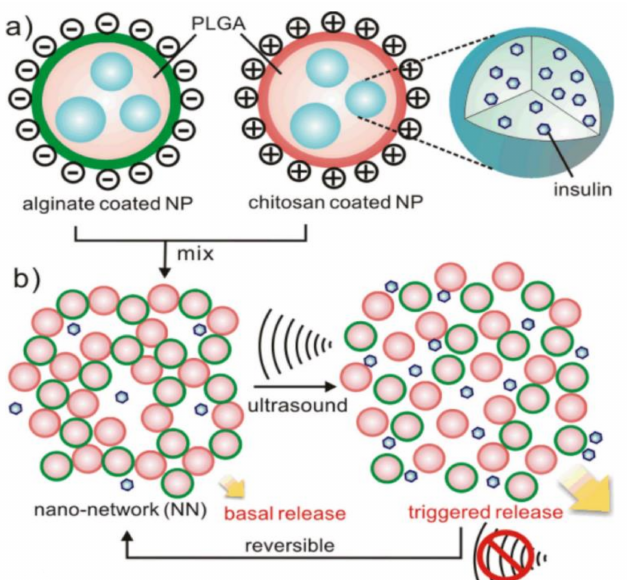
Figure 7. ( a ) Nanoparticles encapsulating insulin are embedded in PLGA and coated with alginate and chitosan. ( b ) A nano-network is formed by combining oppositely charged nanoparticles. It triggers the dissociation of the nano-network and promotes insulin release